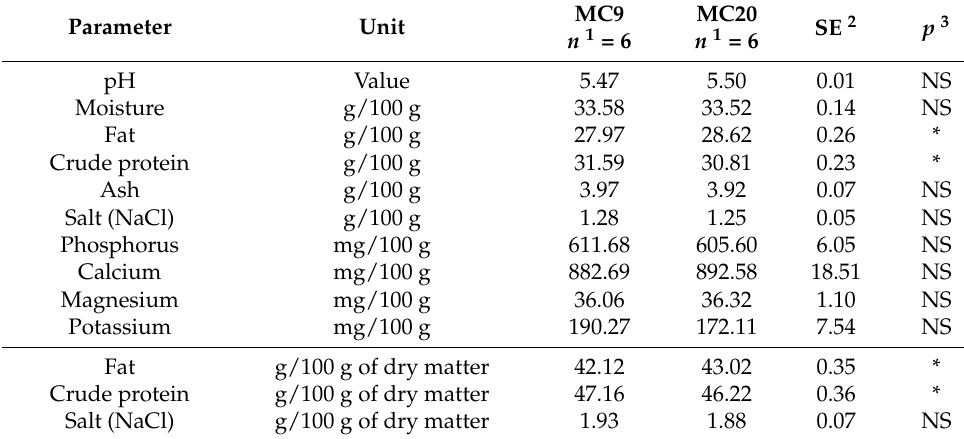
Table 3. Chemical composition of the inner zone of cheese wheels produced by milk kept at the farm at 9 ◦ C (MC9) or 20 ◦ C (MC20) (least-square-mean values).